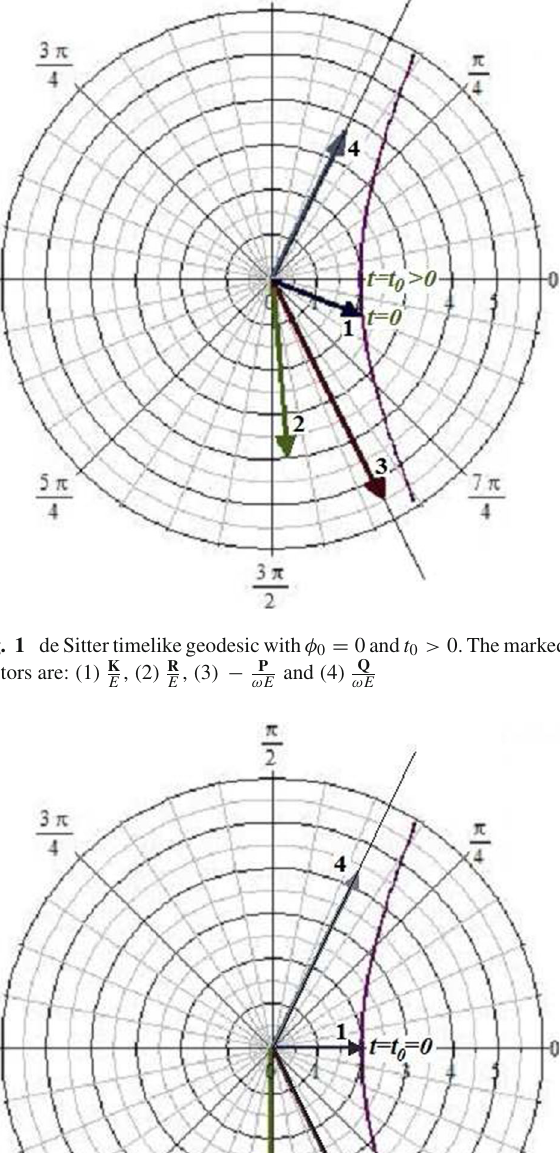
, ( 2 ) R , ( 3 ) − P ω and ( 4 ) Q ω E E E